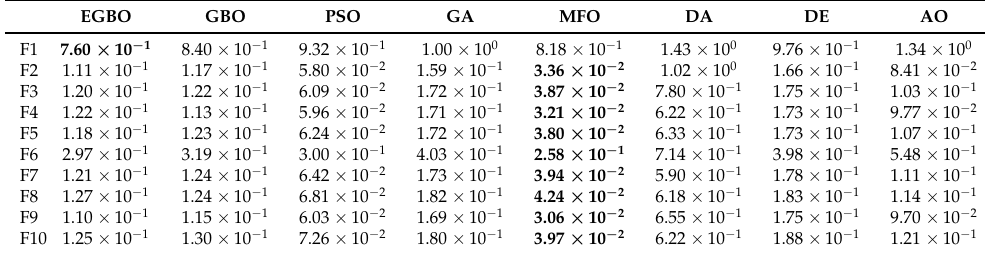
Table 5. Results of the computation times of the fitness function values.